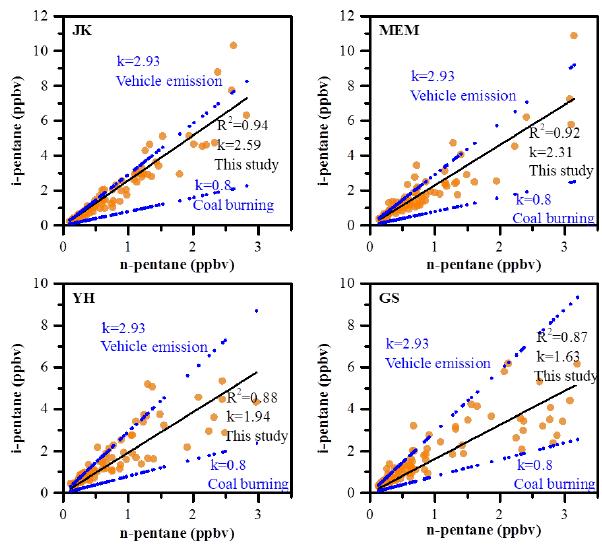
Figure 12. Ratios of isopentane (i-pentane) to n -pentane at every